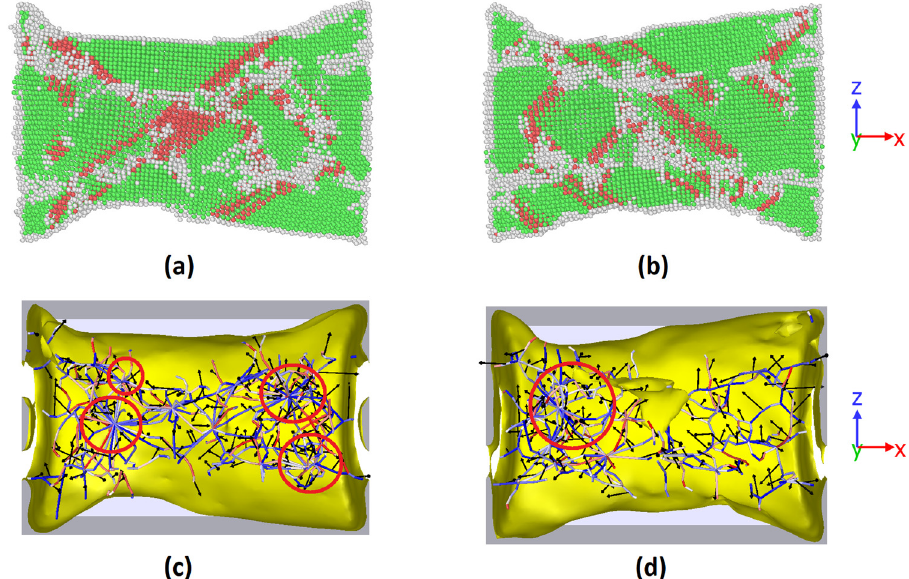
Figure 8: CSP analysis and comparison of crystalline defects at the temperatures of 300 and 600 K: ( a and b ) the stacking fault areas and ( c and d ) dislocation